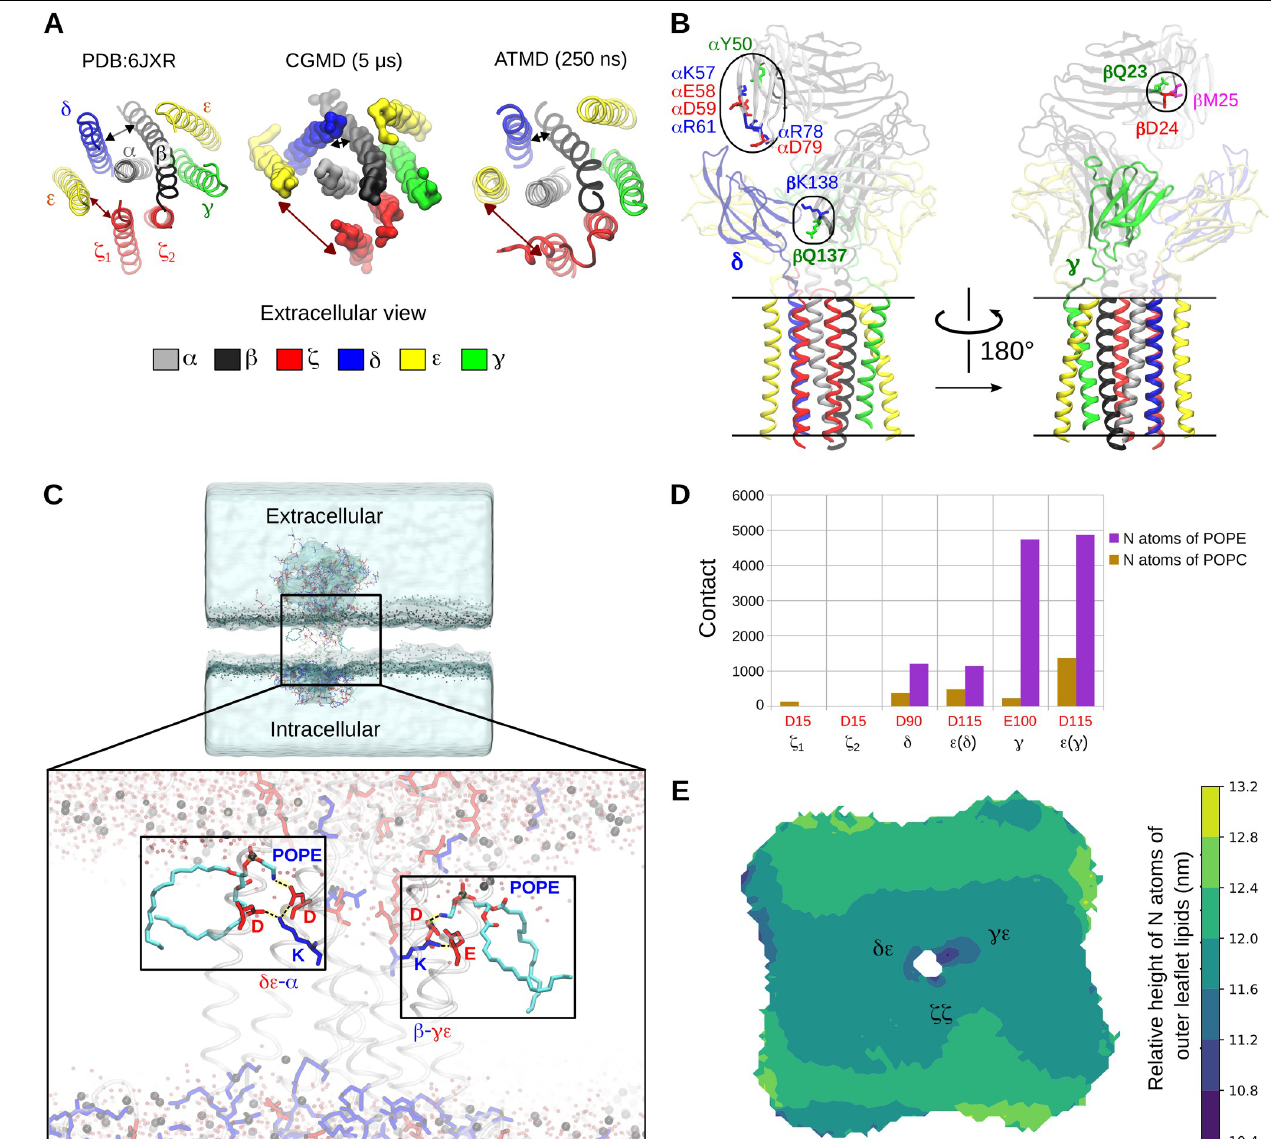
Fig 6. Conformational changes within the TCR-CD3 during our simulations. (A) Extracellular view of the TCR-CD3 TMR conformation from the cryo- EM structure (PDB:6JXR) compared to the TMR conformational change seen in the CGMD simulations. This conformational change was retained in the backmapped ATMD simulations throughout the 250 ns simulation time. (B) New interactions of the TCR α variable domain and of TCR β constant domain with CD3 δ (left), and of the TCR β variable domain with CD3 γ (right) seen in the backmapped ATMD simulations. (C) Snapshot from the end of one of our backmapped ATMD simulations of the entire TCR-CD3. The regions highlighted in boxes show pulled-in POPE headgroups whose amine (NH3) groups interact with the anionic sidechains of CD3 TMRs. The pulled-in POPE lipids are shown in cyan with their oxygen atoms shown in red and nitrogen atoms in blue. Hydrogen atoms are not shown for clarity. Anionic and cationic protein residues are represented as licorice sticks in red and blue, respectively. The TMR helices are shown as transparent cartoons. Water molecules are shown as transparent red spheres and the phosphorus atoms of all phospholipids are shown as black spheres defining the surface of the membrane. (D) Number of contacts of anionic residues of CD3 TMRs with nitrogen (N) atoms of POPC and POPE lipids from all backmapped ATMD simulations combined. (E) Extracellular view of the relative height of nitrogen atoms of all outer leaflet lipids (POPC, POPE, DPSM) mapped as a colour gradient from dark blue (low) to yellow (high). The TCR-CD3 TMR orientation is fixed in the center as shown in